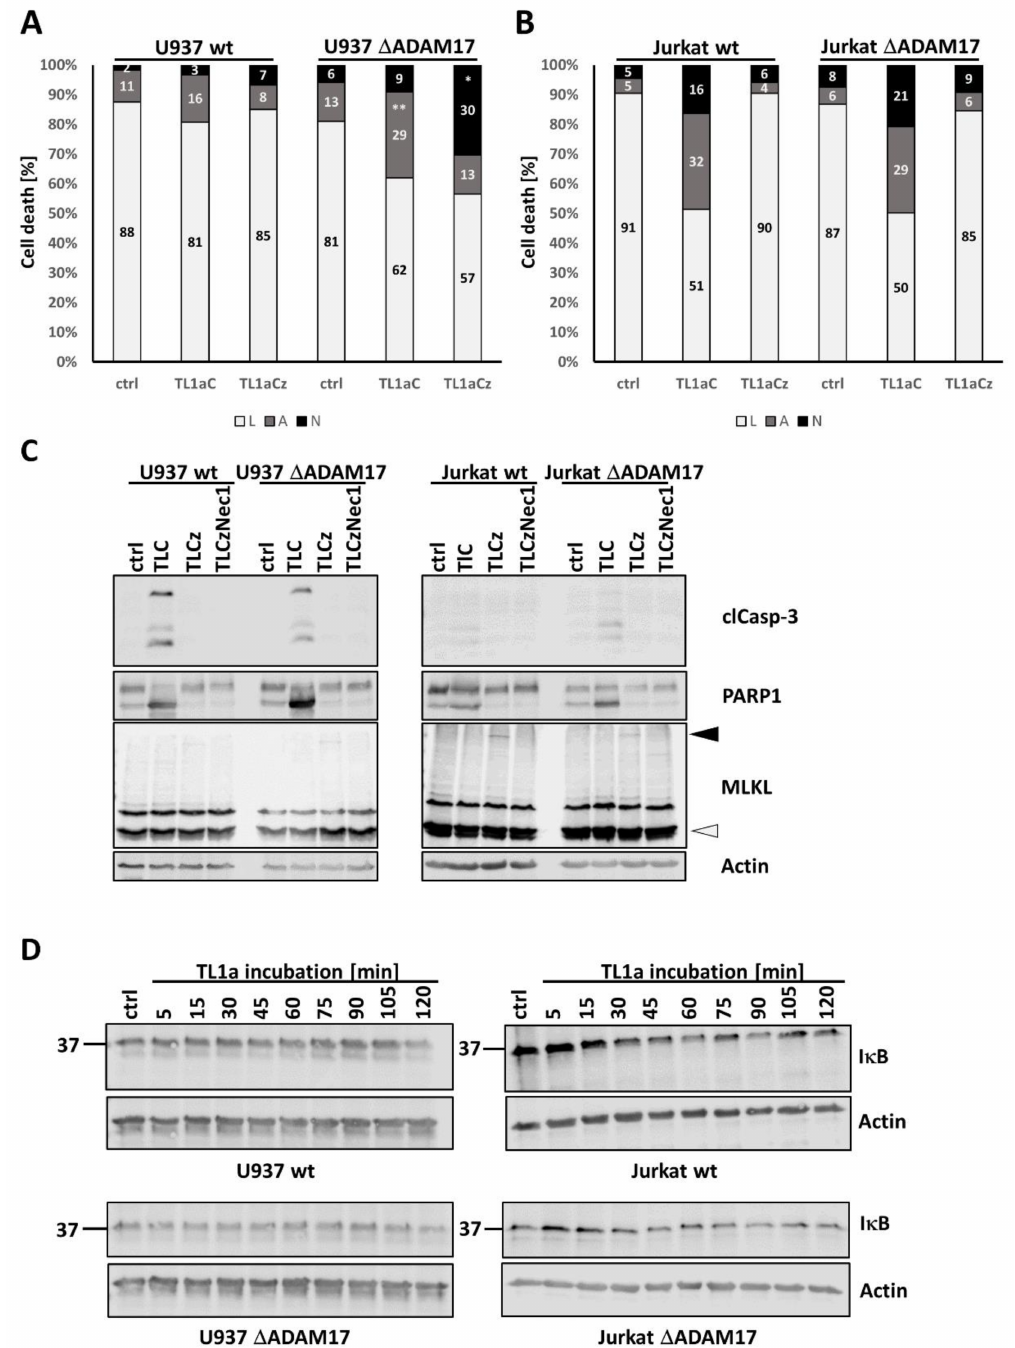
Figure 6. Analysis of ADAM17 and its role in DR3 signal transduction U937 and Jurkat cells. The DR3 ligand TL1a, in combination with CHX or CHC/zVAD, was used to induce cell death in ( A ) U937 and ( B ) Jurkat wt vs. ∆ ADAM17 cells. The percentages of living (L, white), apoptotic (A, grey) and necroptotic (N, black) cells are shown. ( C ) Western bot analysis of TL1a mediated cell death induction in U937 (left panels) and Jurkat (right panels) cells. Membranes were probed for cleaved Caspase 3, PARP1 and MLKL oligomers. Actin was used as loading control. ( D ) Western blot analysis of TL1a mediated I κ B degradation, with Actin as loading control. In all settings, U937 ∆ ADAM17#3 was used. Where applicable, statistical significance based on Student’s t -test is indicated (* p < 0.05; ** p < 0.01). Representative results of at least n = 3 experiments are